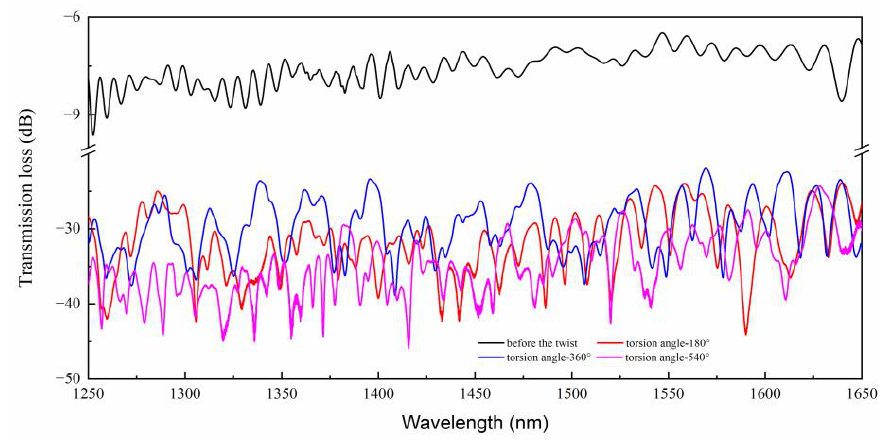
Figure 2. Measured transmission spectra of the MZI without and with HS structure.